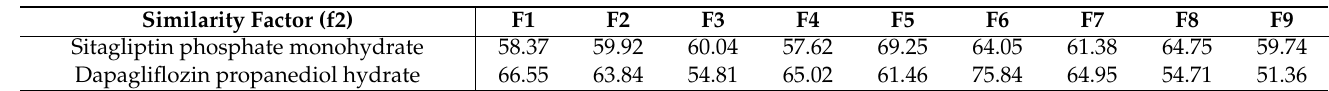
Table 14. Assay test results of the reference drug and sitagliptin phosphate monohydrate-dapagli- fl ozin propanediol hydrate FDC tablets for 3 months ( n = 3).